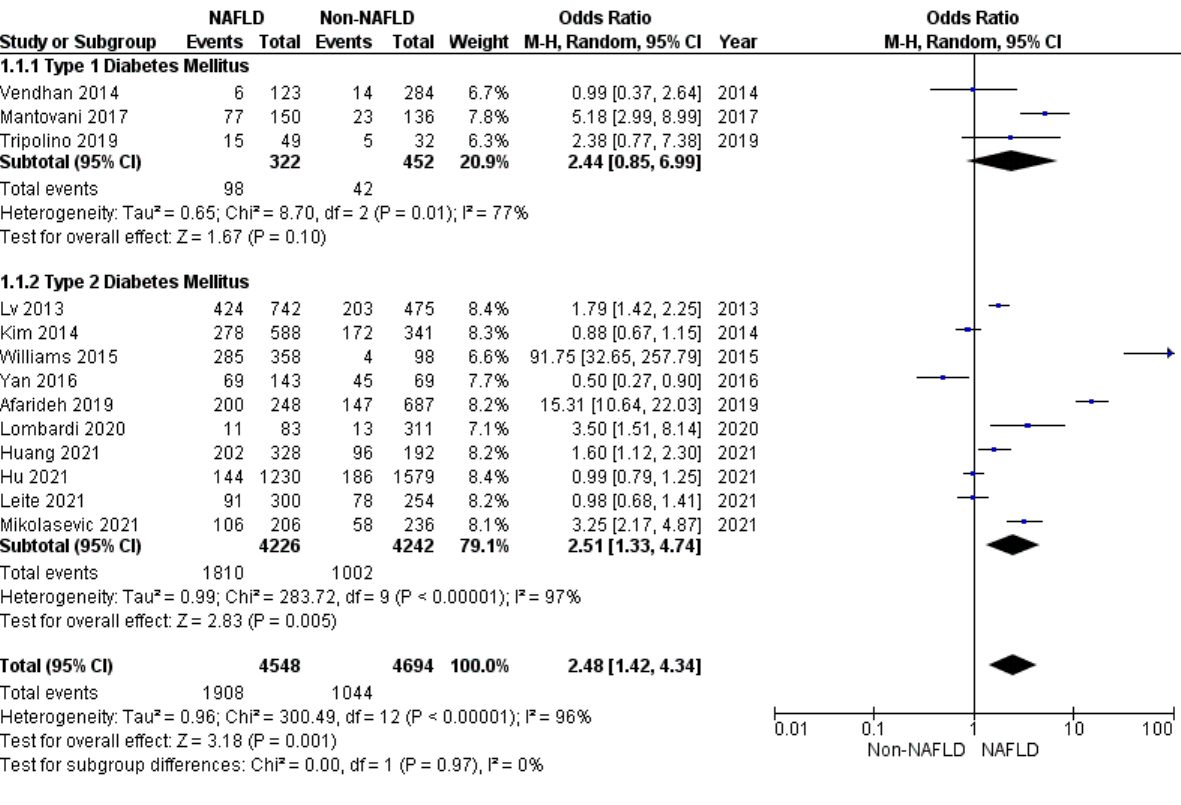
Figure 2. Forrest plot displaying the prevalence of peripheral neuropathy expressed as odds ratio, comparing diabetic patients with and without NAFLD.